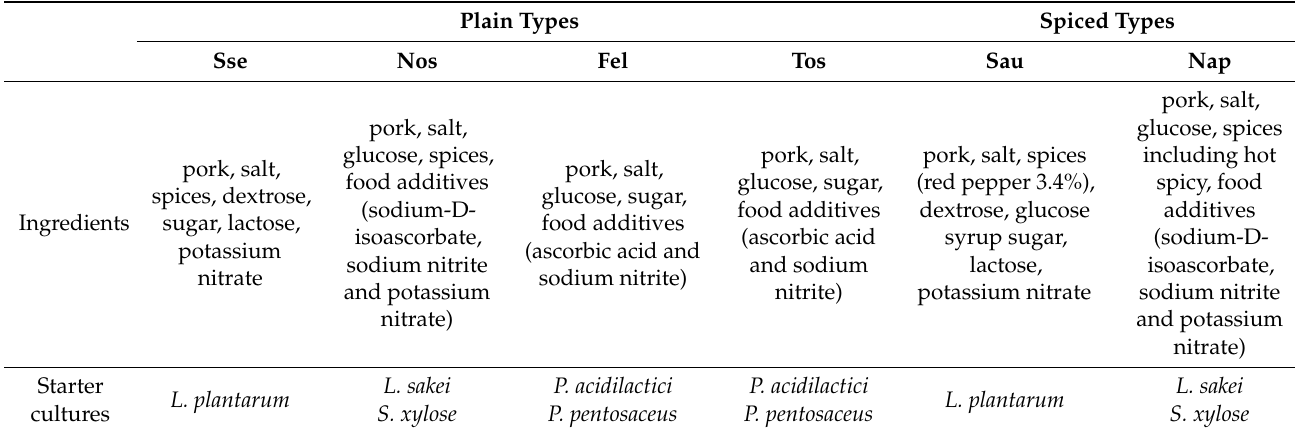
Table 1. Ingredient information of six commercial fermented salami from